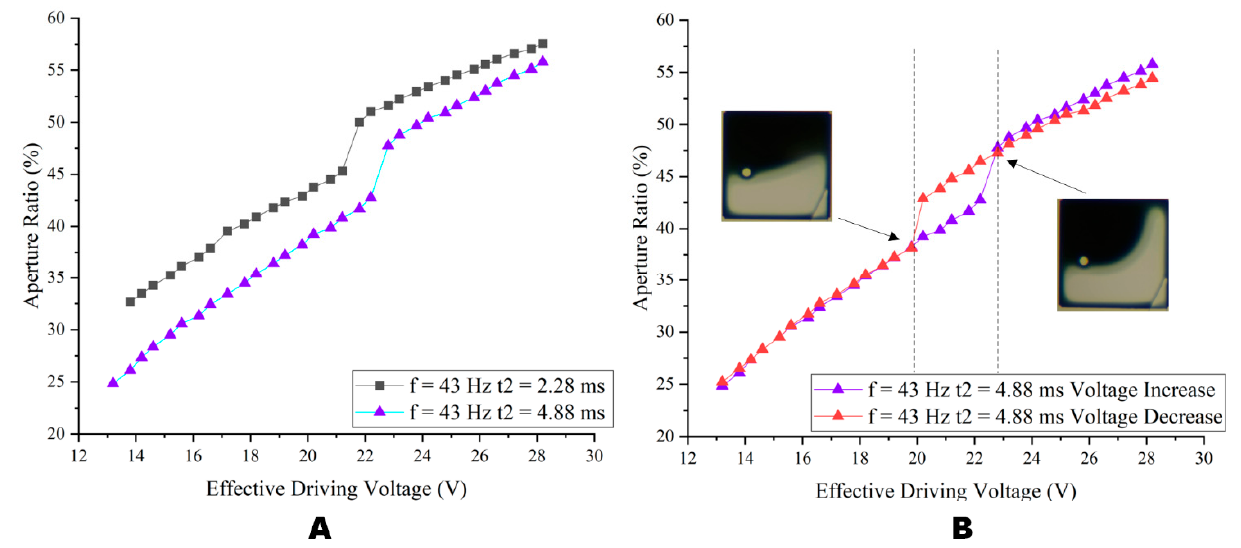
Figure 10. The relationship between the V base and aperture ratio. ( A ) The aperture ratio of the ITO- EWD was tested when the V base increased from 13 V to 28.8 V. ( B ) The aperture ratio of the ITO-EWD was tested when the voltage increased from 13 V to 28.8 V and decreased from 28.8 V to 13 V. When the 𝑉 (cid:3029)(cid:3028)(cid:3046)(cid:3032) voltage was between 19.8 V and 22.8 V, there was an obvious aper-